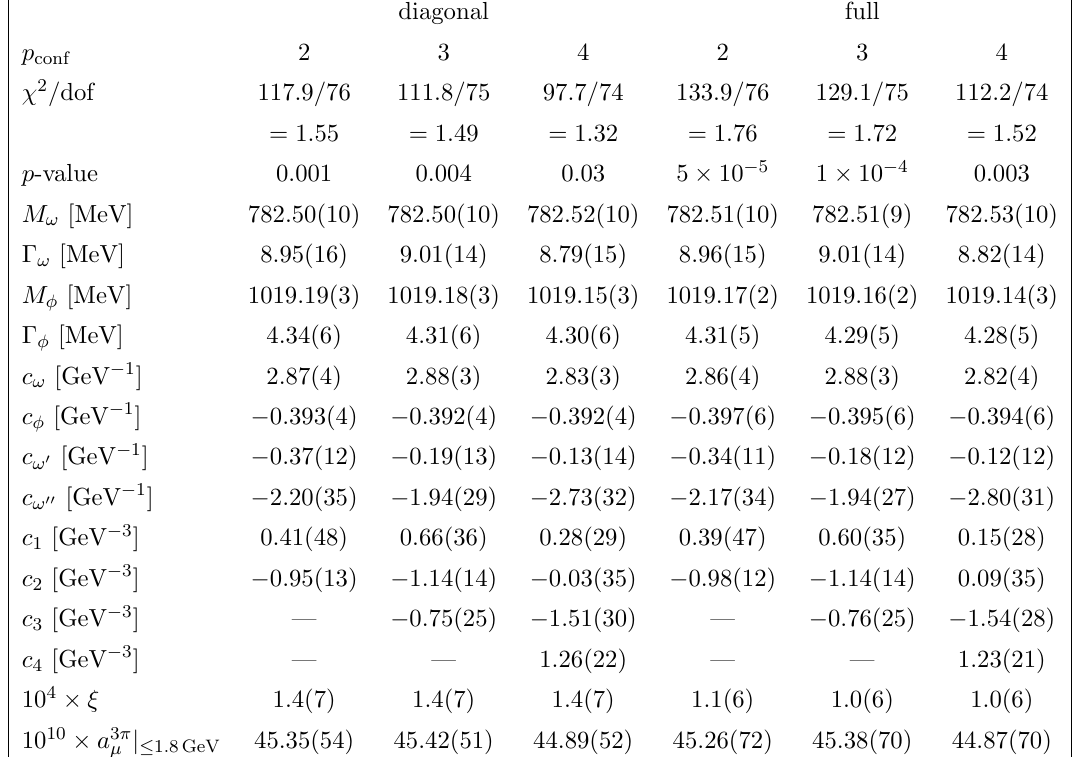
Table 5 . Fits to the combination of the CMD-2 data sets [63, 75] and BaBar [68], with modi(cid:12)cations to [75] as described in the main